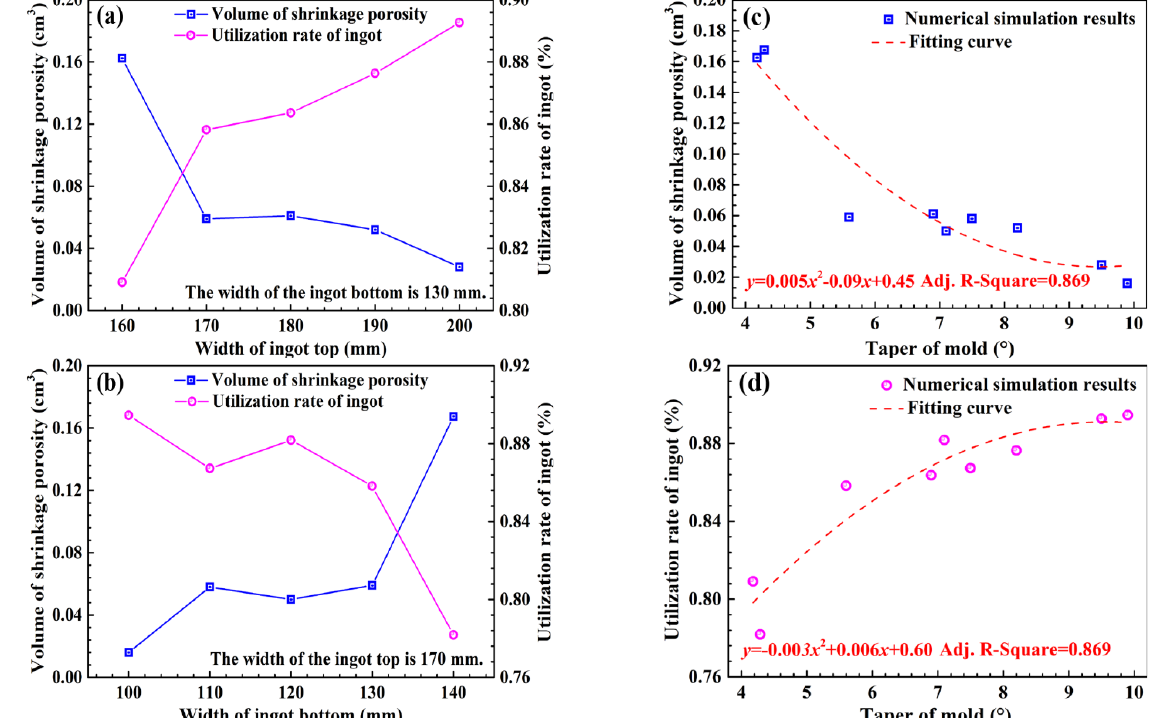
Figure 12. Effect of top width ( a ), bottom width ( b ), and mold taper ( c , d ) for ingots on shrinkage porosity and utilization rate of ingots.